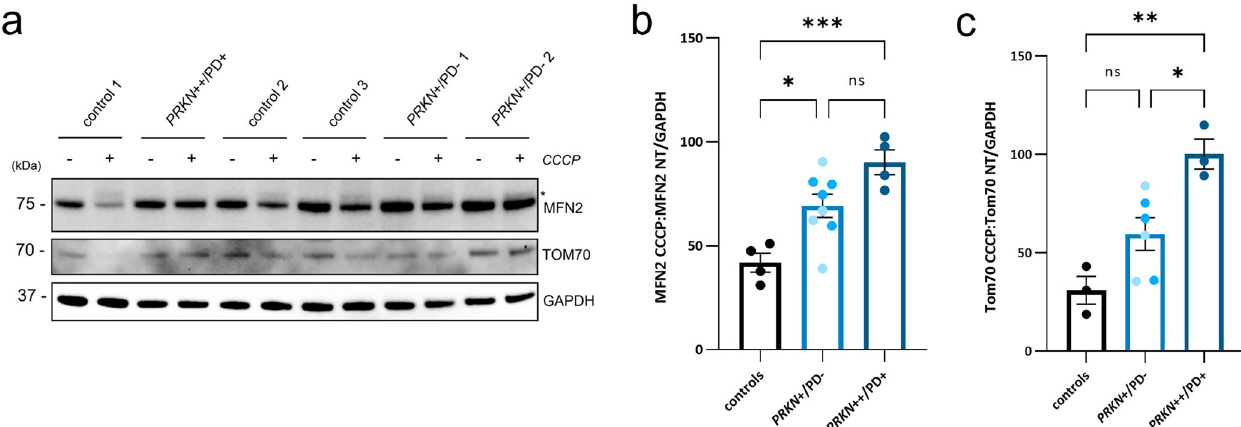
Fig. 6 Elevated steady-state levels of OMM proteins upon stress in hiPSC-derived neurons of heterozygous PRKN variant carriers. a Representative Western blot showing MFN2 and TOM70 protein levels in the hiPSC-derived neurons under basal conditions ( − ) and treated with 20 µM CCCP for 15 h ( + ). The asterisk indicates the monoubiquitinated form of MFN2. b , c Densitometric analysis of protein bands of a PD patient with homozygous PRKN mutations ( PRKN ++ /PD + ), the carriers group ( PRKN + /PD − ) comprising two heterozygous carriers ( PRKN + /PD − 1 and PRKN + /PD − 2, respectively color coded) and the control group (representing the mean values of three control lines per experiment). MFN2 and TOM70 levels were analyzed with the indicated antibodies, and GAPDH was used as a loading control. Molecular mass markers are in kilodaltons (kDa). For both OMM proteins, levels were calculated as the ratio of MFN2 or TOM70 upon CCCP treatment over the levels of MFN2 or TOM70 under basal conditions (non-treated, NT). n = 3 – 4 independent experiments, respectively. The error bar represents the mean ± SEM. Signi fi cance levels were determined using one-way ANOVA and Tukey ’ s post hoc test to correct for multiple comparisons. * p ≤ 0.05, ** p ≤ 0.01, *** p ≤ 0.001. ns not signi fi